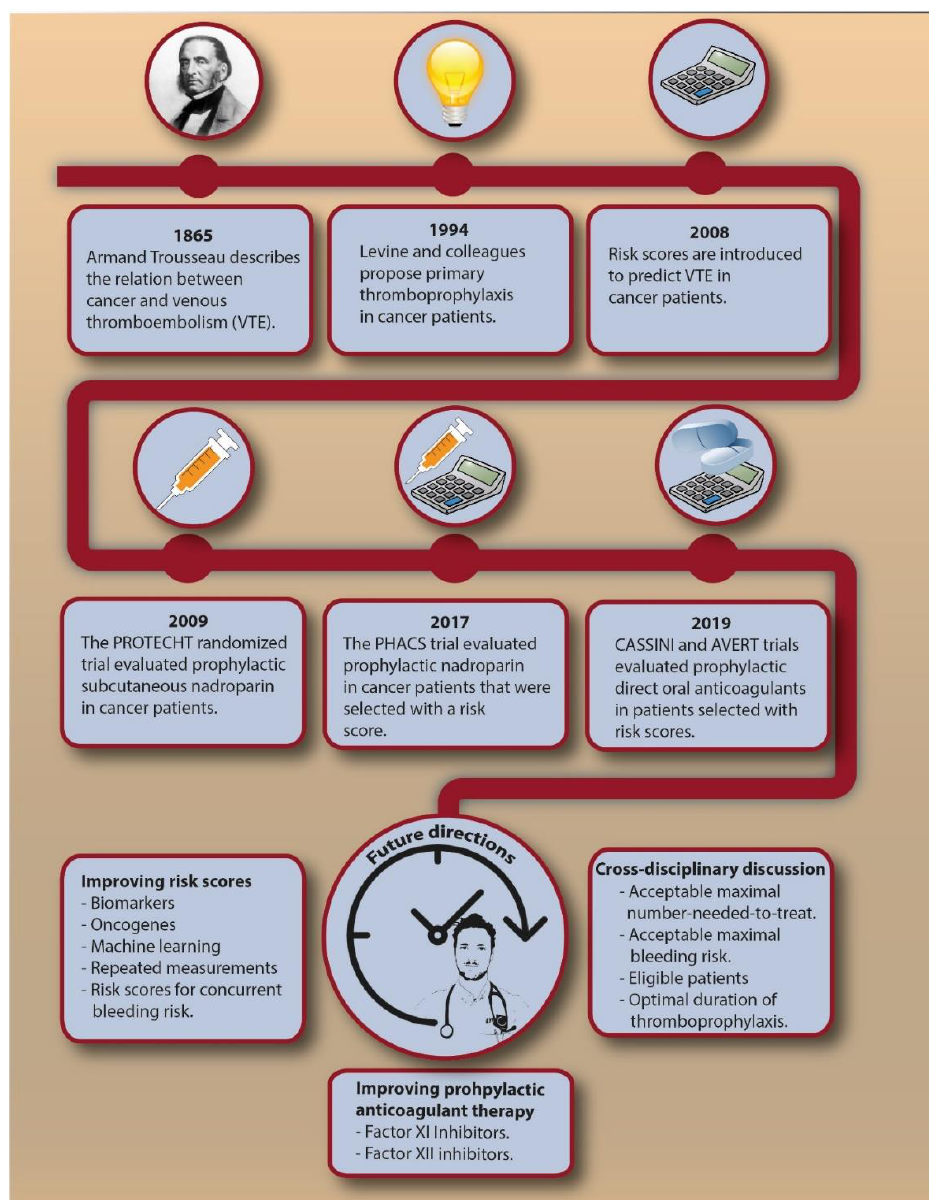
Figure 2. The chronological introduction of primary thromboprophylaxis in cancer patients and possible future directions. Abbreviations: NNT, number needed to treat; VTE, venous thromboembolism.